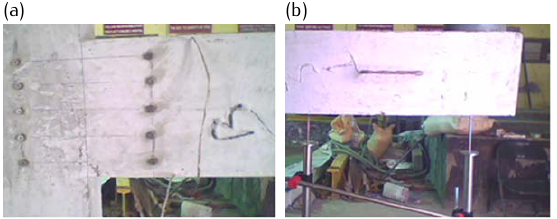
Figure 6. (a) Typical specimen with Demec pellets; (b) Positions of LVDT.